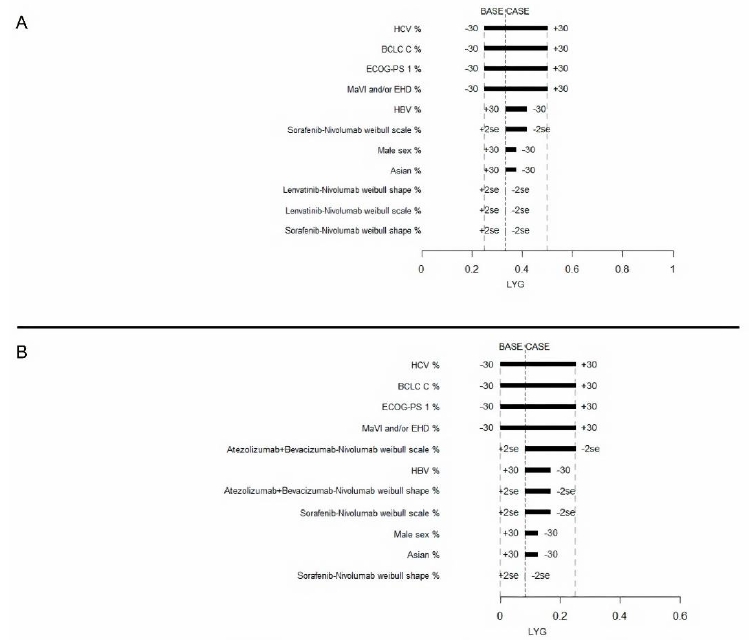
Figure 3. Tornado diagram for the one-way sensitivity analysis of variables influencing LYG of advanced HCC patients treated with Lenvatinib-Nivolumab ( A ) or Atezolizumab plus Bevacizumab-Nivolumab ( B ). Both were compared to the Sorafenib-Nivolumab treatment. Compared to Atezolizumab plus Bevacizumab followed by Nivolumab, the ISER of Lenvatinib followed by Nivolumab was 32% of SAEs for LYG. One-way sensitivity analysis of the ISER also showed